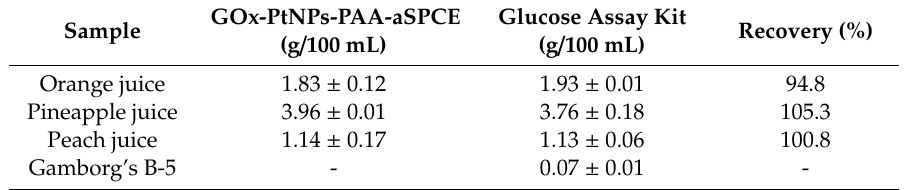
Table 2. Determination of glucose in real samples using a reference spectrophotometric